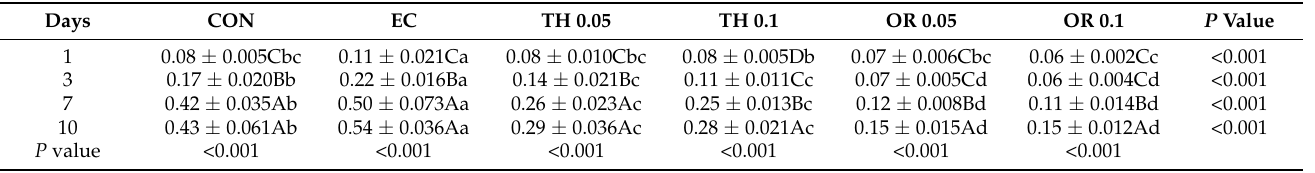
A, B, C: different upper letter means statistical differences between the treatments within the display ( P < 0.05). a, b, c: different lower letter means statistical differences between displays within the treatment ( P < 0.05). CON: patties uncoated; EC: patties with edible coating; TH 0.05: patties with edible coating with 0.05% thyme EO; TH 0.1: patties with edible coating with 0.1% thyme EO; OR 0.05: patties with edible coating with 0.05% oregano EO; OR 0.1: patties with edible coating with 0.1% oregano